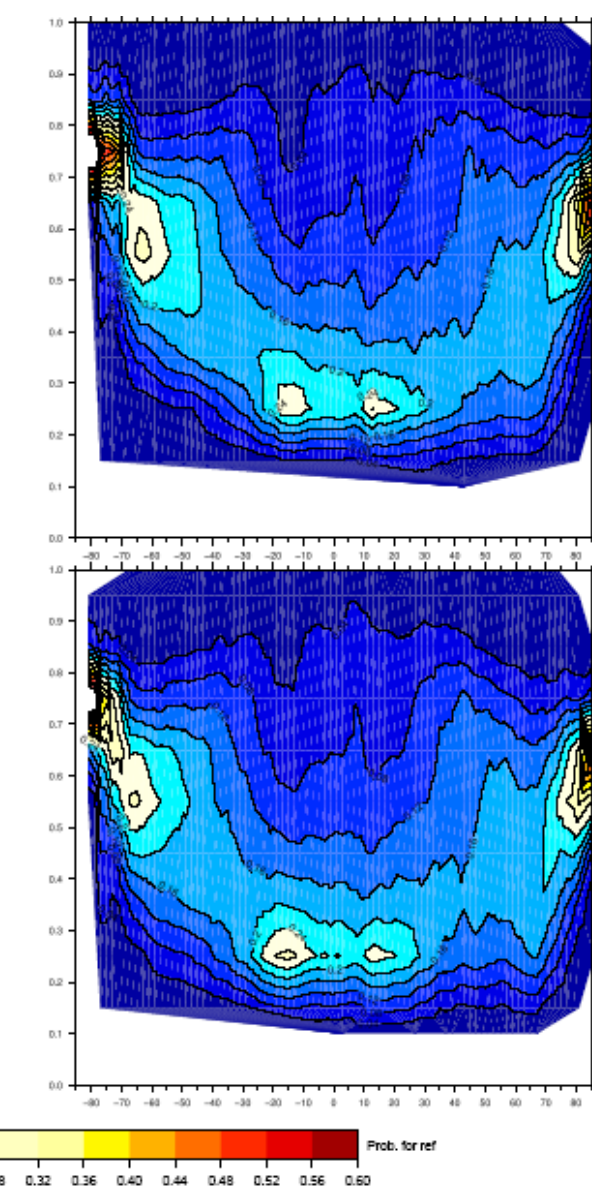
Figure 5. The probability plot of reflectivity (443nm) for 2003–2006 (Top: 2003 (left) and 2005 (right), Bottom: 2004 (left), 2006 (right)). OX: latitude (degrees), OY:CTH